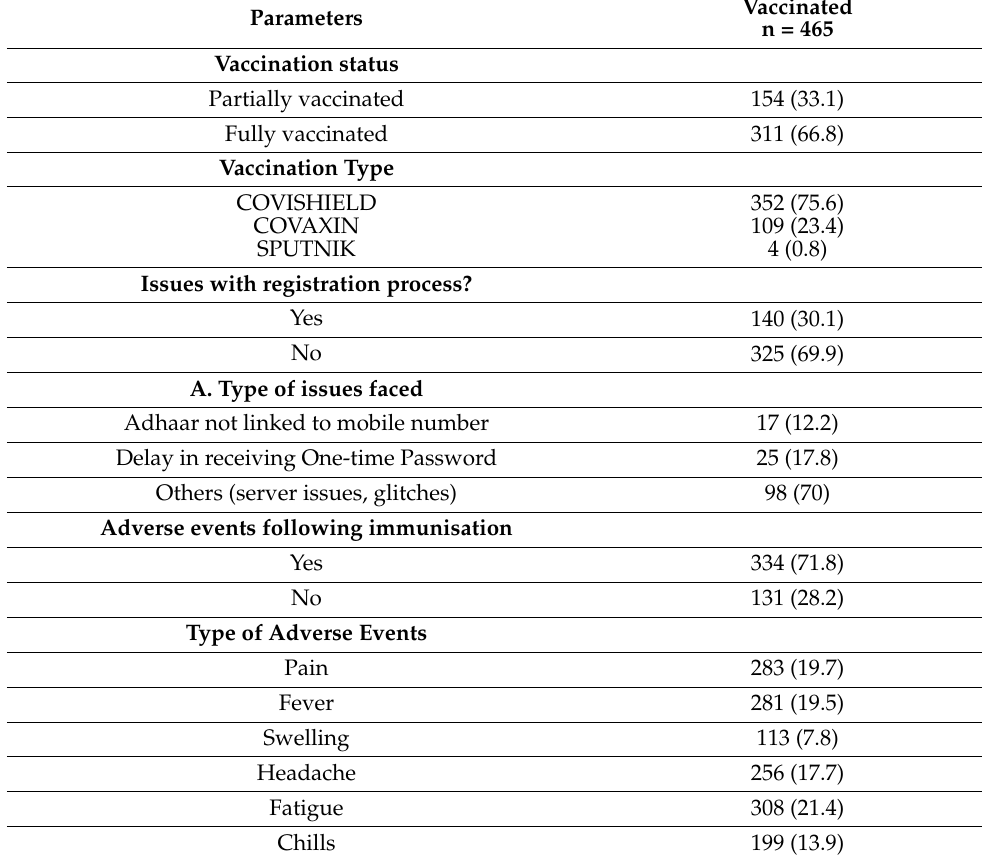
Table 2. Specific characteristics among vaccinated participants.